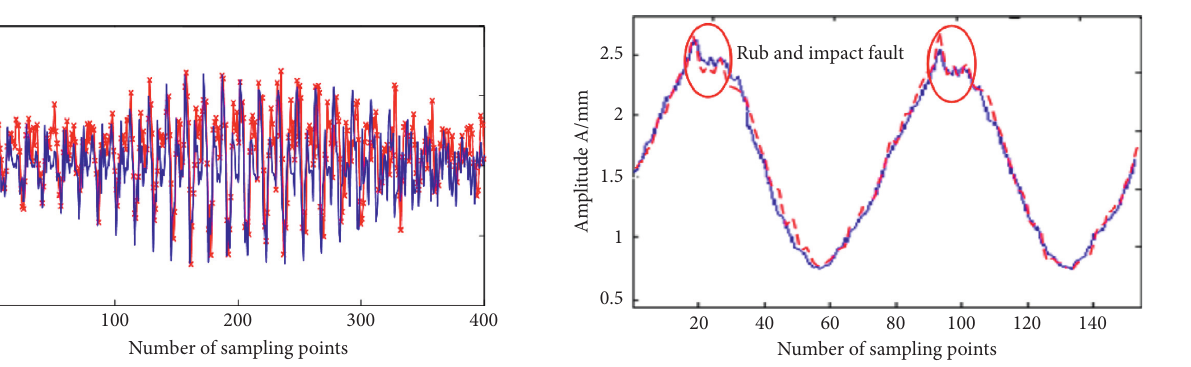
Figure 18: Comparison results of two methods for processing the impact wear